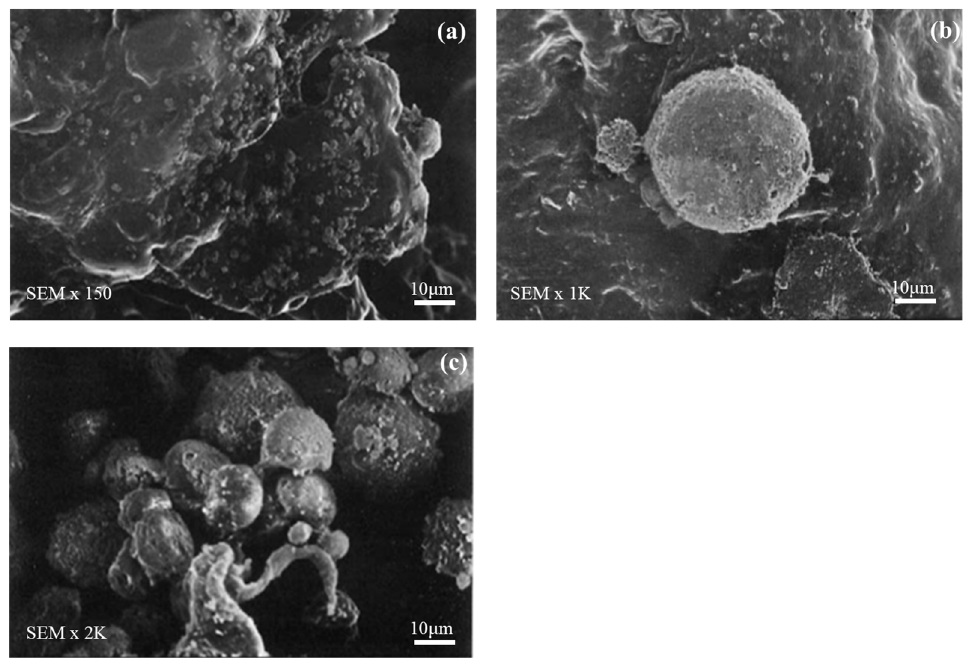
Figure 6. SEM micrographs: ( a ) ES cells of PLGA (150); ( b ) ES cells of PLGA (1 K); and ( c ) ES cells of PLGA (2 K).